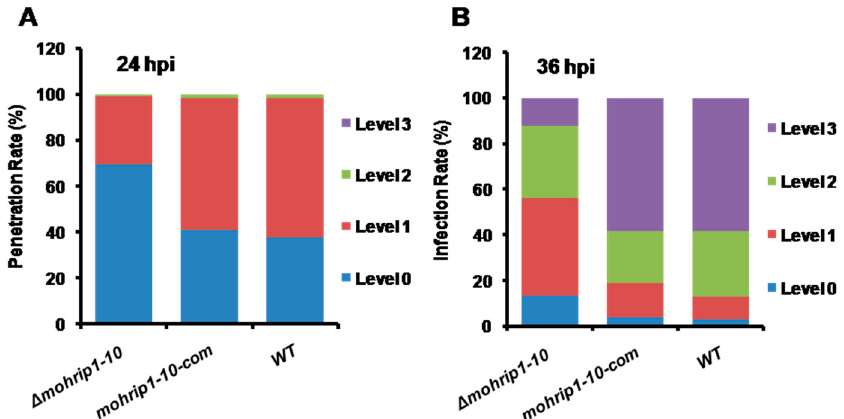
Figure 5. MoHrip1 is important for M. oryzae penetration and proliferation. According to the four levels (Level 0, just appressoria without penetration; Level 1, with penetration peg or primary IH; Level 2, with sparse secondary IH restricted in the first infected rice cell; Level 3, with abundant IH in the initial and even neighboring rice cells) we divided in another research, the infection status of rice leaf sheaths inoculated with M. oryzae strains (5 × 10 4 conidia ml − 1 in 0.2% Tween 20) was respectively investigated at 24 hpi and 36 hpi. ( A ) Statistical analysis of the penetration rates of M. oryzae strains at 24 hpi. ( B ) Statistical analysis of the infection rates of M. oryzae strains at 36 hpi. Data are representative of three independent assays, each assay with three repeats. For each repeat, at least 100 appressoria were observed. ∆ mohrip1-10 , mohrip1-10-com and WT respectively represent one deletion mutant, one complementation mutant and the wild type strain.